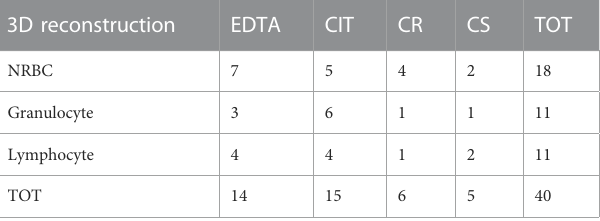
TABLE3Listofcellsundergoing3Dreconstruction,subdividedbycelltypeand tube. 3D